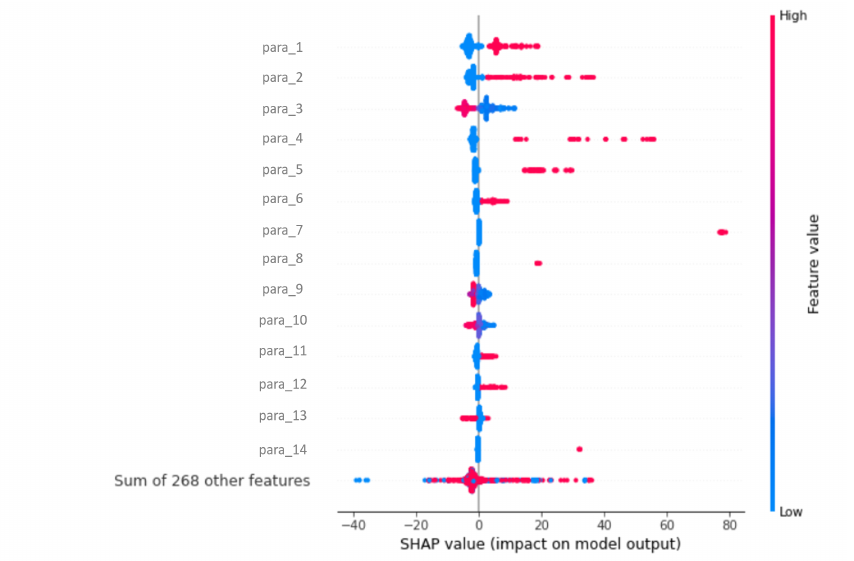
Figure 6. SHAP summary plot of ET model for the training